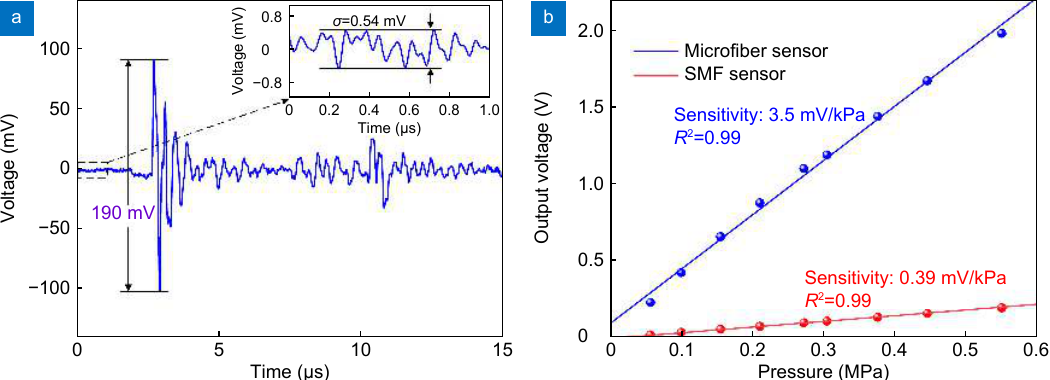
Fig. 3 | ( a ) Time response of the sensor to an ultrasound pulse. ( b ) Ultrasound pressure sensitivities of microfiber sensor and SMF